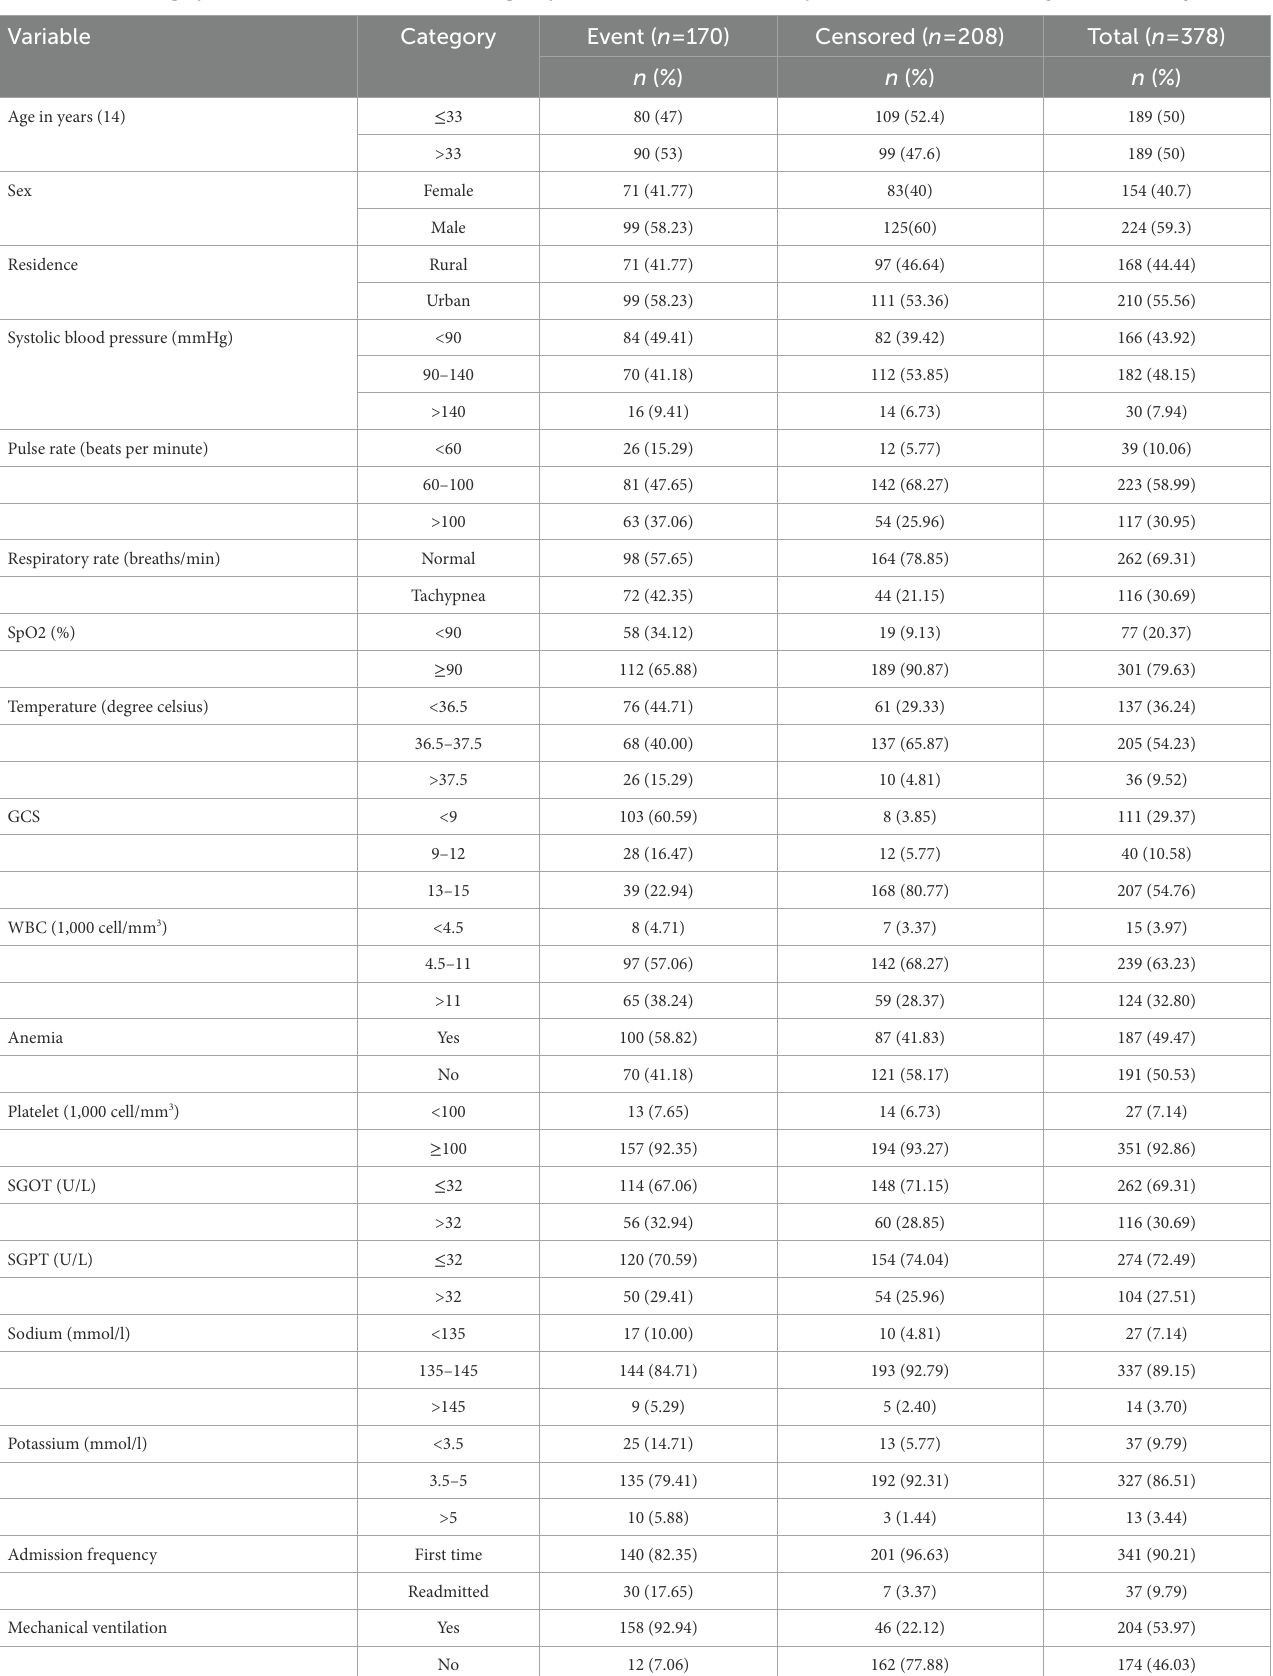
TABLE 1 Socio-demographic and clinical characteristics of surgical patients admitted to ICU of hospitals in Addis Ababa, February 2017 – February 2020.